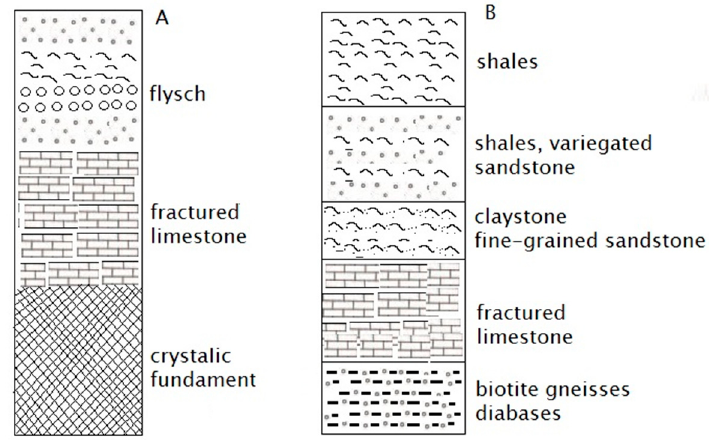
Figure 2. General statigraphic lithology at: Podhale basin—( A ) follows Chowaniec [13], and Ustro ń 3—( B ) follows Soko ł owski and Kempkiewicz